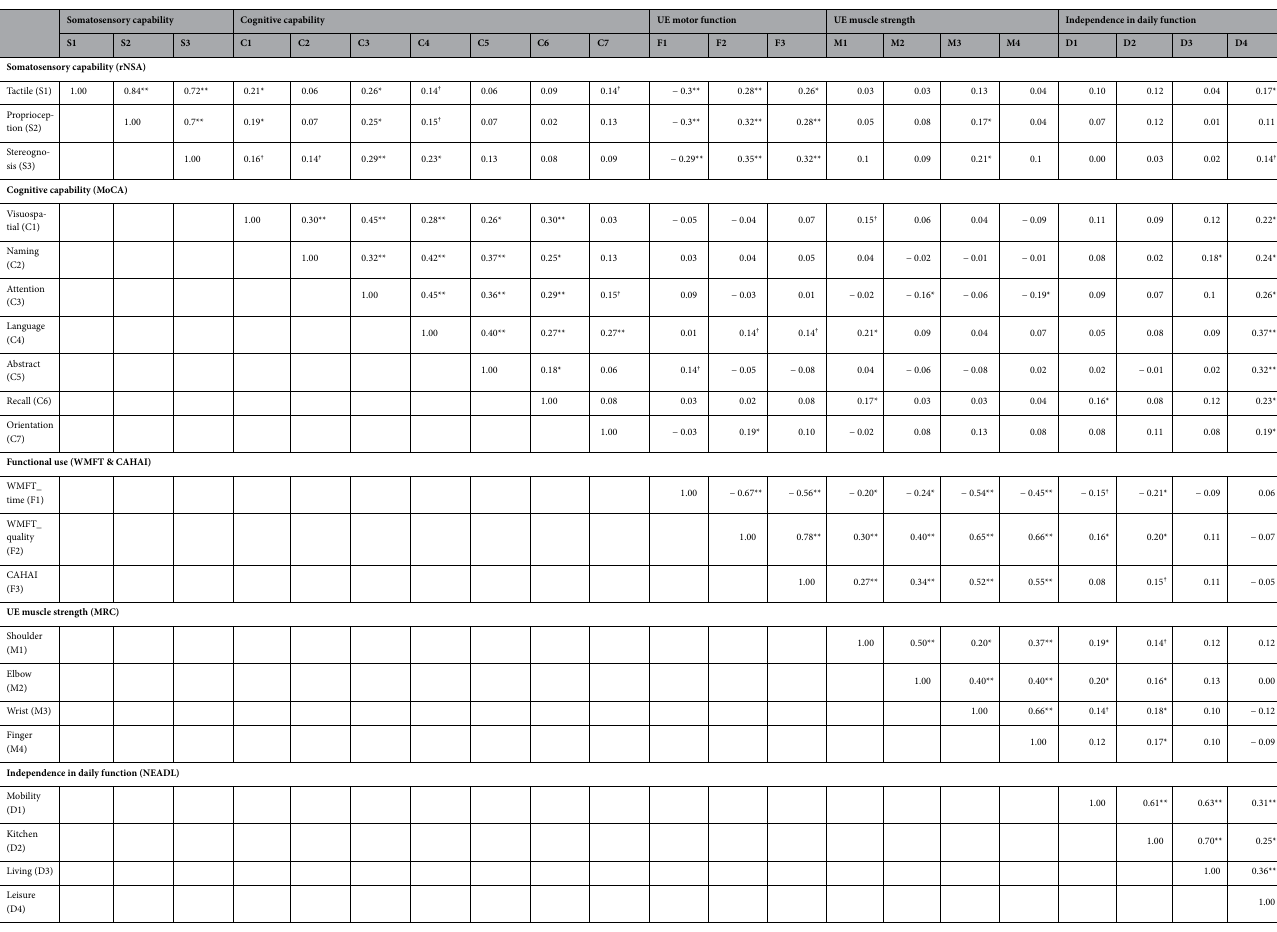
Figure 2b shows the path diagram of the revised model. All model-fitting indices showed good fit ( χ 2 = 195.954, df = 181, P = 0.212; χ 2 / df = 1.083; CFI = 0.988; RMSEA = 0.023; SRMR = 0.064). In the standard- ized results, the somatosensory capability positively influenced the UE motor function performance (β = 0.368, P < 0.001) and the cognitive capability (β = 0.292, P = 0.001) but negatively influenced the UE muscle strength (β = − 0.202, P = 0.004). The UE motor function significantly influenced the UE muscle strength (β = 0.909, P < 0.001), and the UE muscle strength significantly influenced the independence in daily function (β = 0.208, P = 0.020).